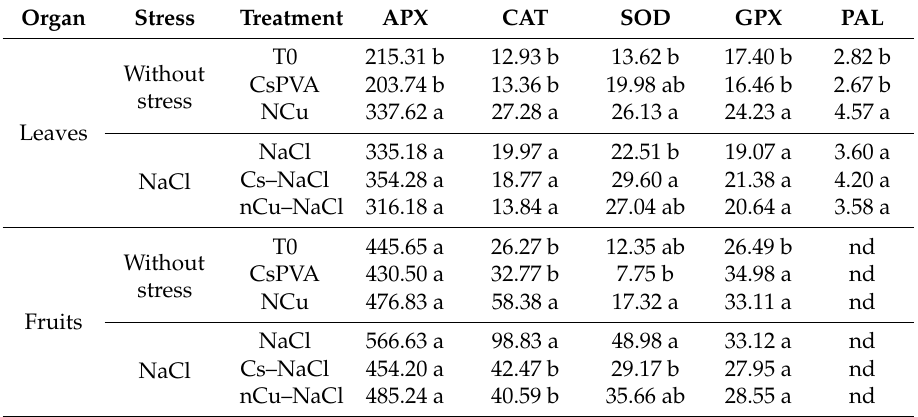
Table 3. Enzymatic activity in tomato leaves and